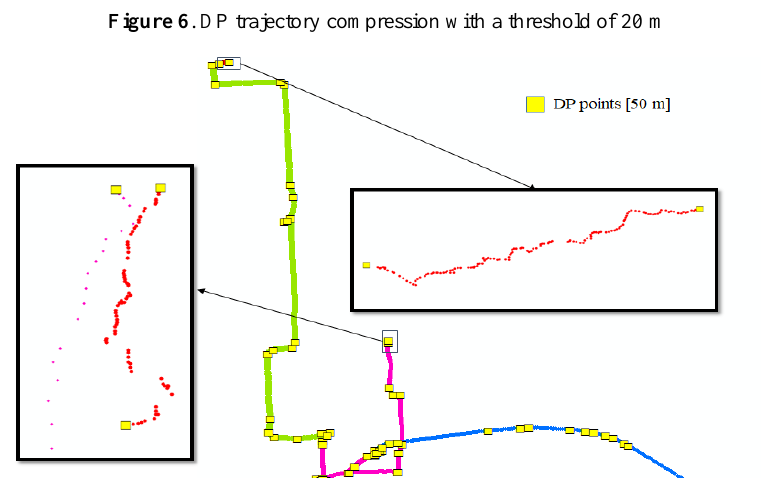
Figure 6 . DP trajectory compression with a threshold of 20 m